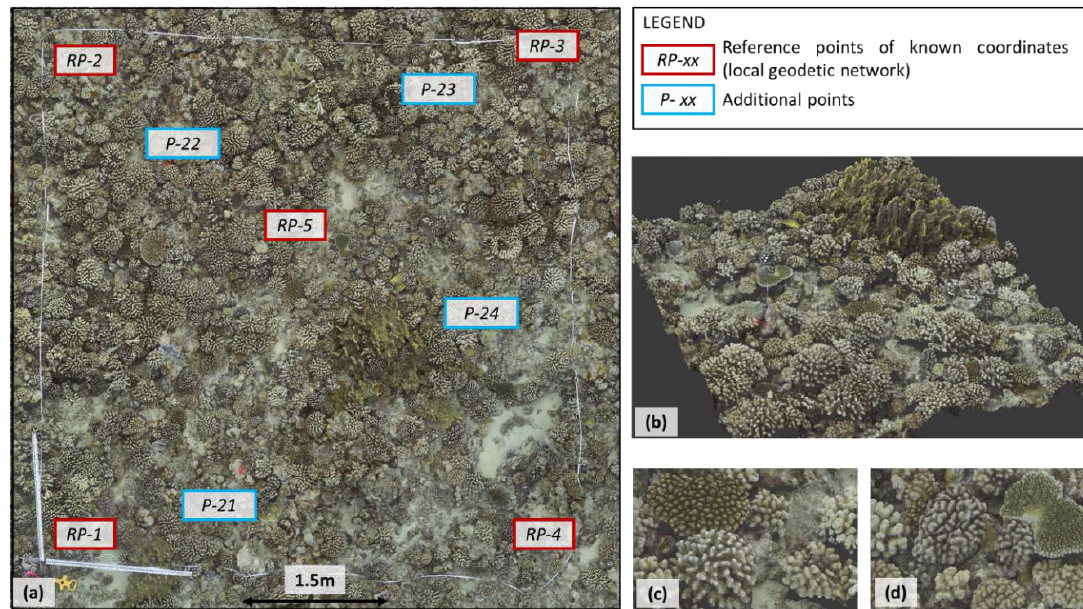
Figure 2. (a) Orthoimage of the test area no. 18. Marked are 9 signalized (coded targets) points. (b, c, d) Particulars of the dense point